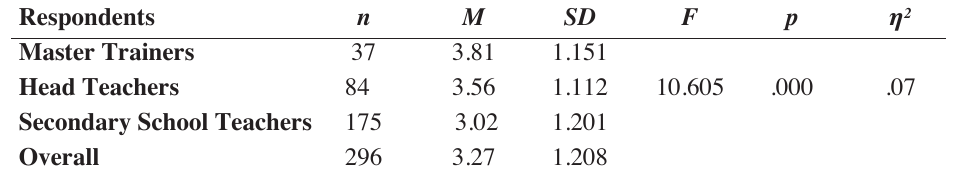
Table.19 Table.19 Use of ICT helps teachers to understand difficult concepts in a more effective